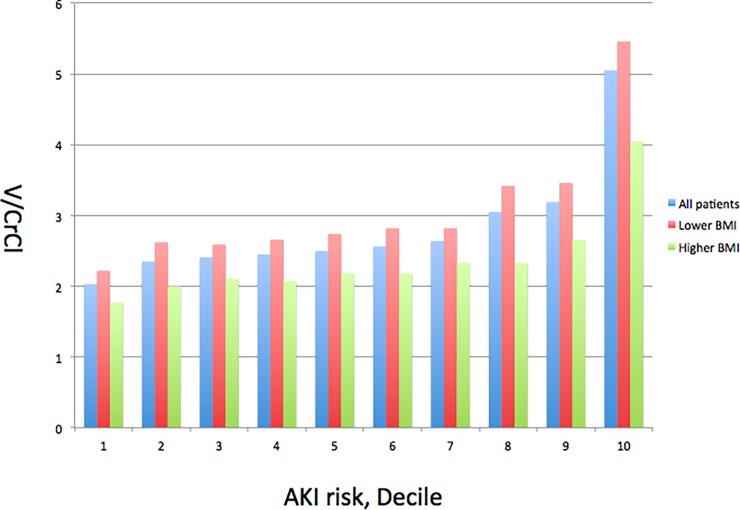
Mean V/CrCl ratio compared to AKI risk decile for all patients, the low-BMI group, and the high-BMI group.V/CrCl, contrast volume to creatinine clearance ratio; AKI, acute kidney injury; BMI, body mass index.